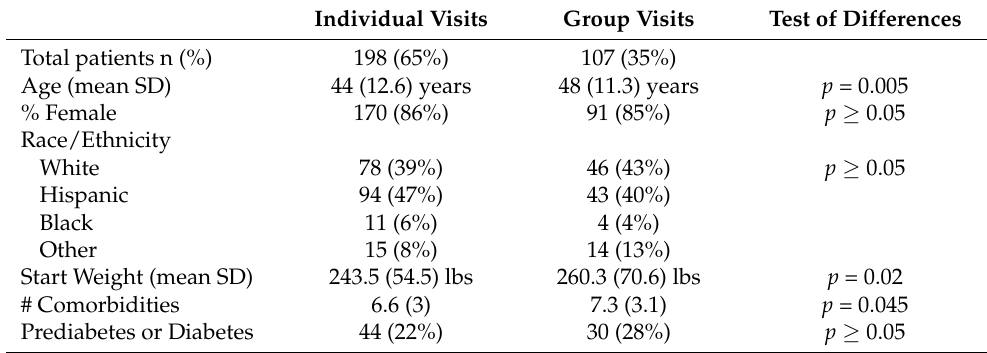
Table 1. Baseline characteristics in Individual Medical Visits (IMV) and Group Medical Visits (GMV). Individual Visits Group Visits Test of